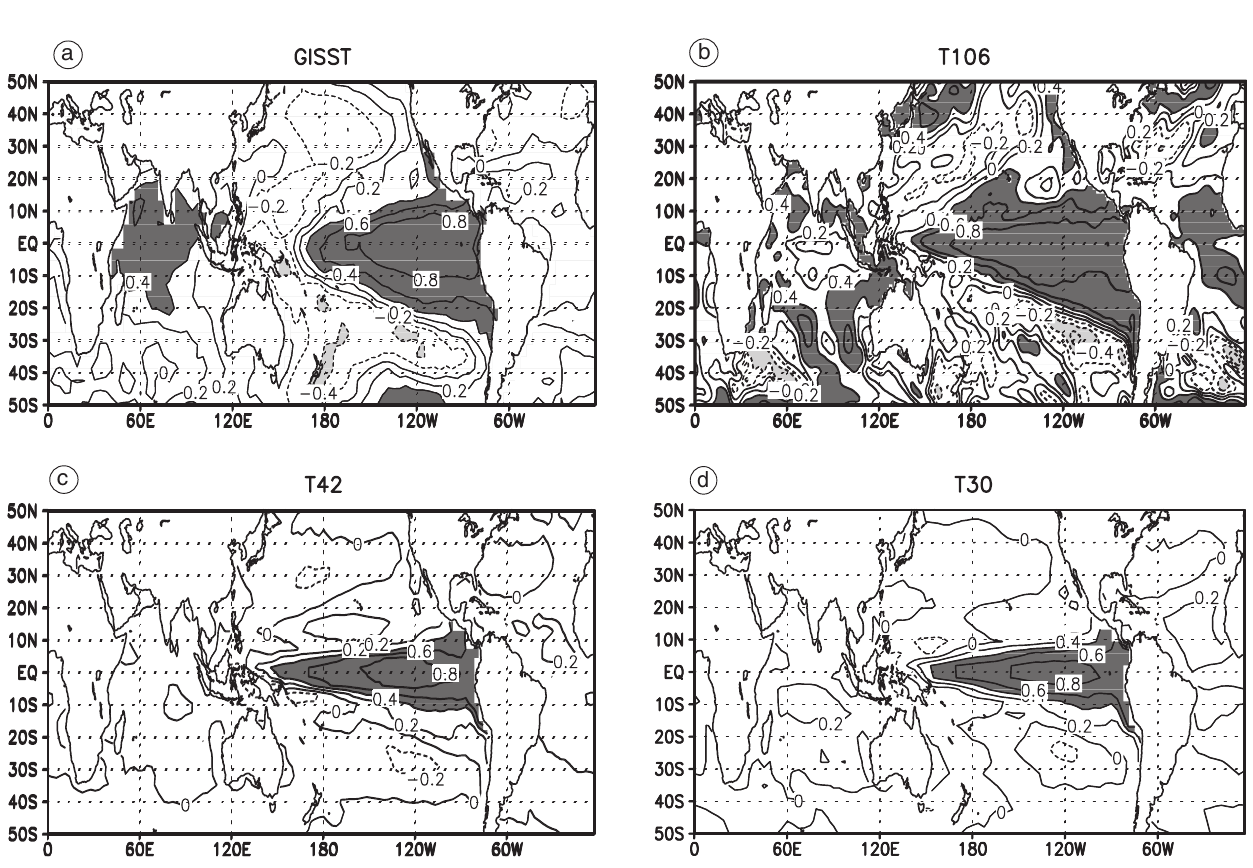
Fig. 16a-d. Maps of correlation of the NIÑO-3 SSTA with the global SST anomaly. Panel a): GISST case; panel b): T106 experiment; panel c): T42 experiment; panel d): T30 experiment. Contour line interval is 0.2; dashed contour lines indicate negative values; shaded areas indicate values larger than | 0.4 | ; the shaded contour interval is